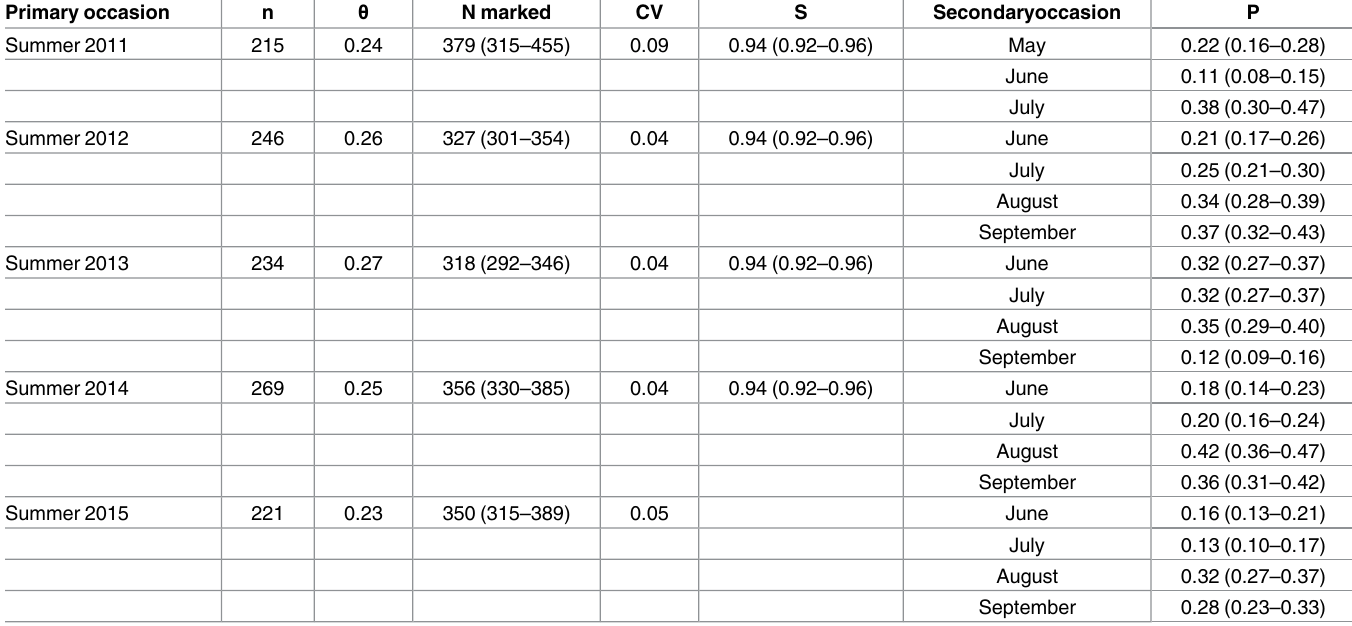
Table 4. Parameterestimates(with 95% confidence interval) for best model for the striped and common dolphin dataset; n = number of photo- identified individuals (D1), θ = mark ratio, N marked = estimatedabundance of D1 individuals; CV = coefficient of variation, S = apparent survival probability; p = capture probability.